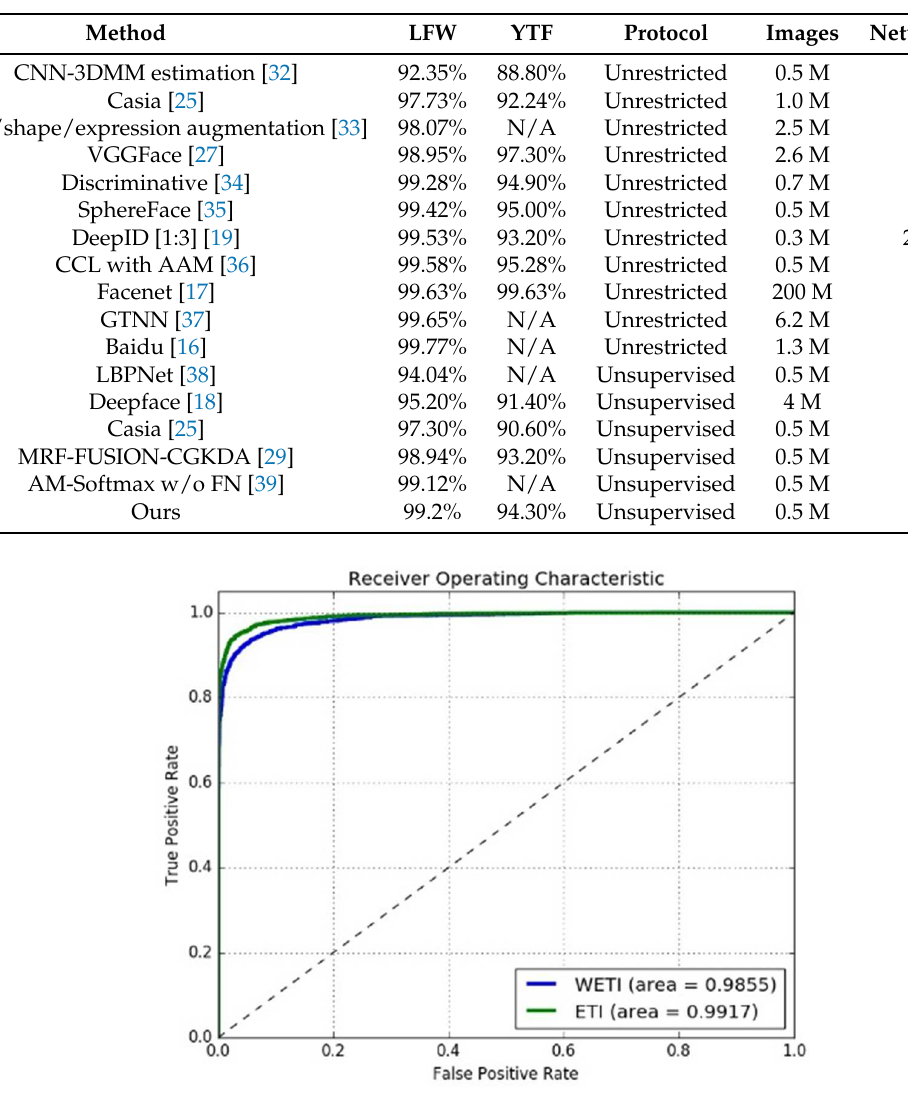
Figure 17. ROCs with unsupervised verification protocol on LFW dataset for without enough training images (WETI) and enough training images